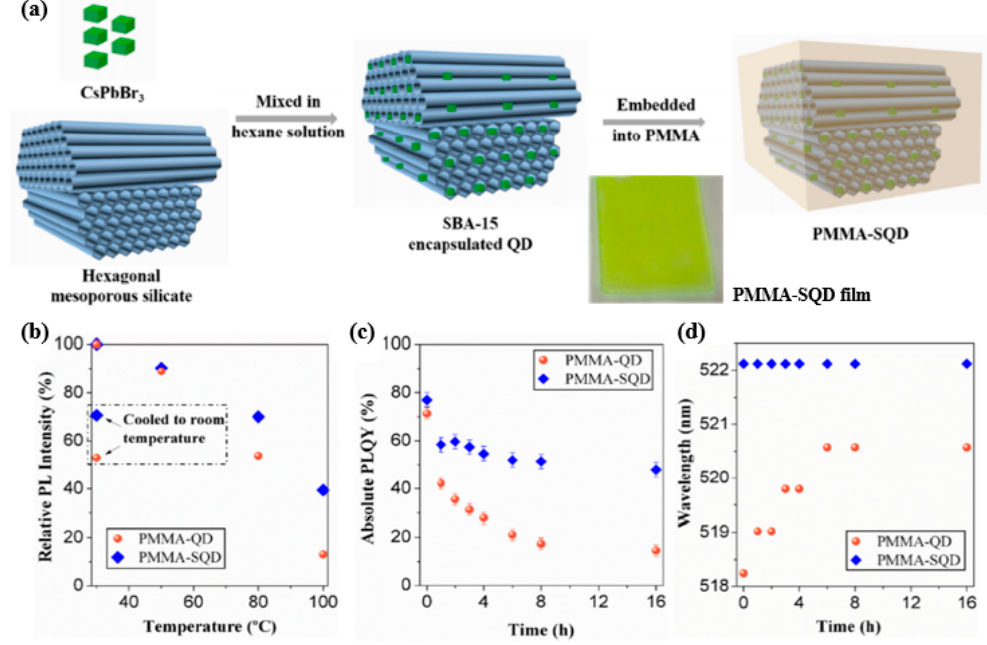
Figure 16. ( a ) A schematic diagram for the preparation process of PMMA-SQD composites; ( b ) the relative PL intensity as a function of heating temperature from 30 ◦ C to 100 ◦ C; ( c ) the PLQY values and ( d ) PL peak wavelength as a function of time when the films continuously heated at 80 ◦ C [82]. Figure reproduced with permission from Optical Society of America.